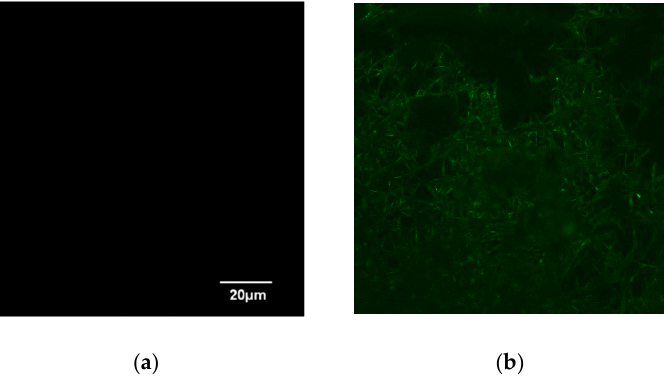
Figure 5. LSCM images of ( a ) IMAM and ( b ) GFP-His 6 -adsorbed IMAM.